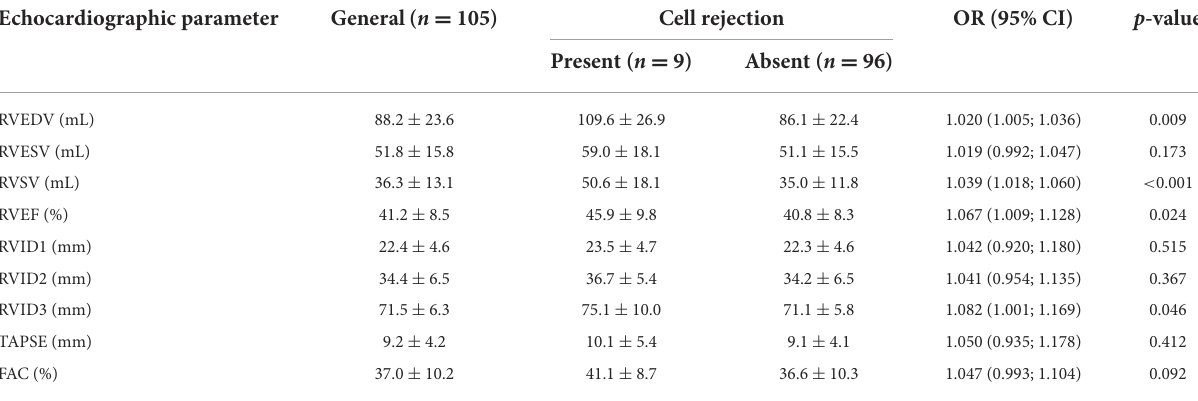
TABLE 10 Morphological and functional echocardiographic parameters of the right ventricle according to cellular rejection. Echocardiographic parameter